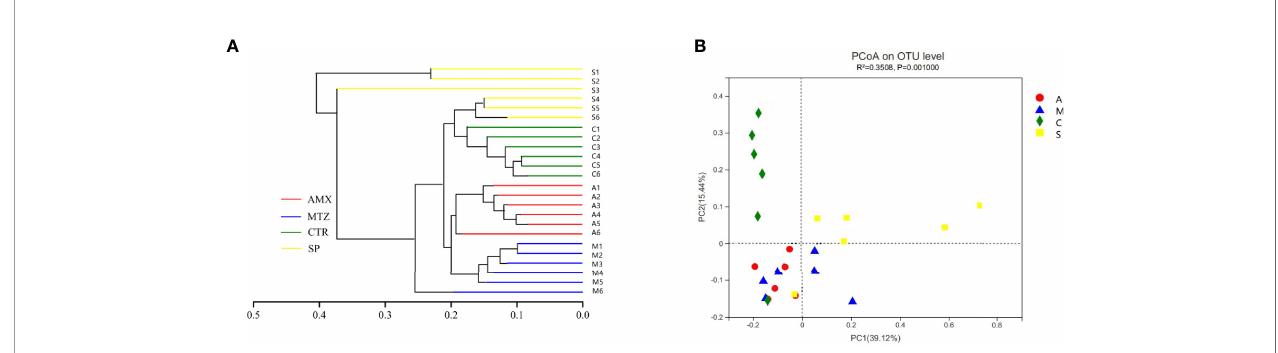
FIGURE 5 | Relationship of the rats oral microbiota from different groups. (A) Clustering tree of the oral microbiotas in different rats from Amoxicillin (AMX), Metronidazole (MTZ), Control (Con), spiramycin (SP).Oral microbiota trees were generated using the UPGMA (unweighted pair group method with arithmetic mean) algorithm based on the Bray-Curtis distances generated by Mothur. (B) Principal coordinate analysis (PcoA) of community structure of the oral microbiotas of the four groups. Amoxicillin (red), Metronidazole (blue), Spiramycin (yellow) and Control (green) shapes represent the oral microbiotas from each groups, respectively. Distances between symbols on the ordination plot re fl ect relative dissimilarities in